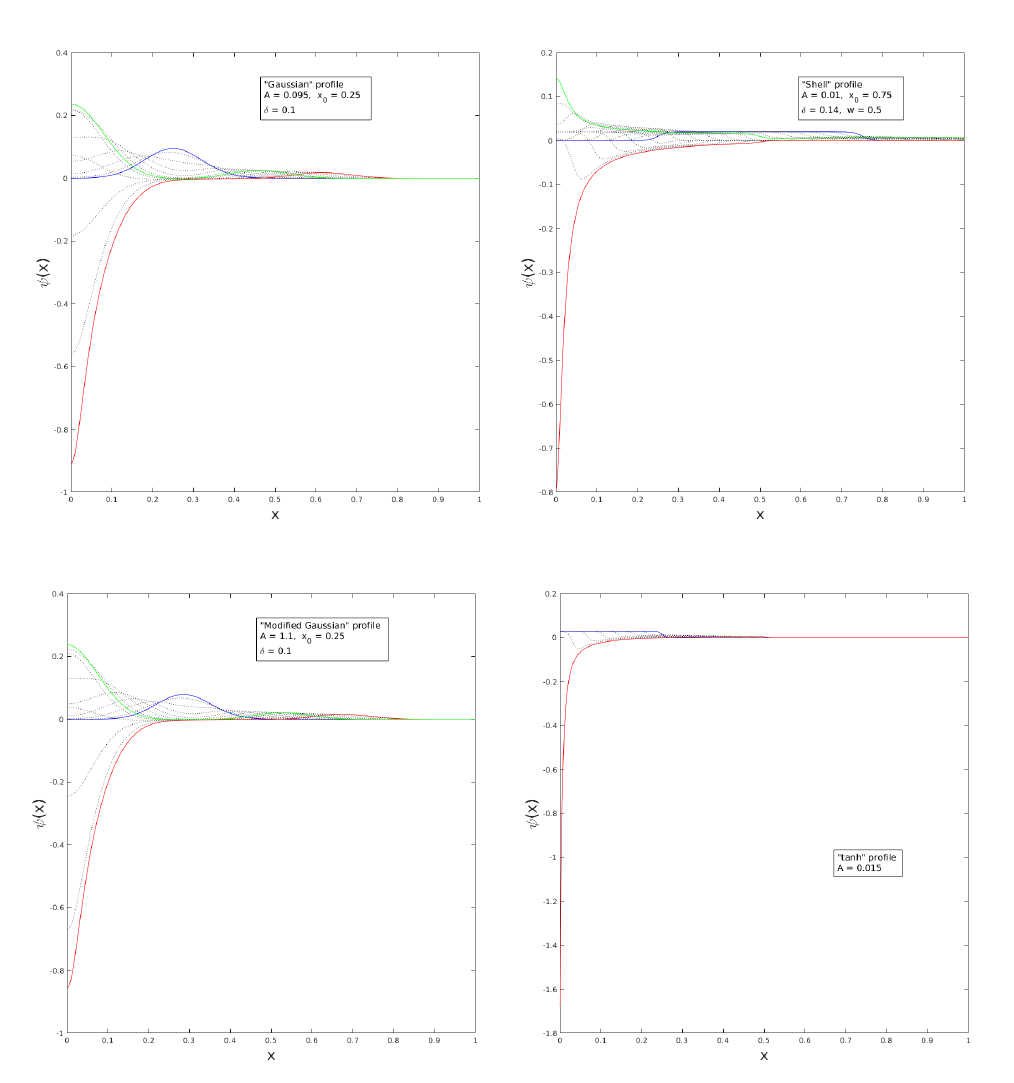
Figure 2: The spatial profiles at various times of different representative super-critical initial scalar profiles. We use the notation, ψ ( x ) ≡ φ ( t , x ) / is blue, the maximum value at the origin with the specific choice of parameters is attained for green, and red indicates a late-time